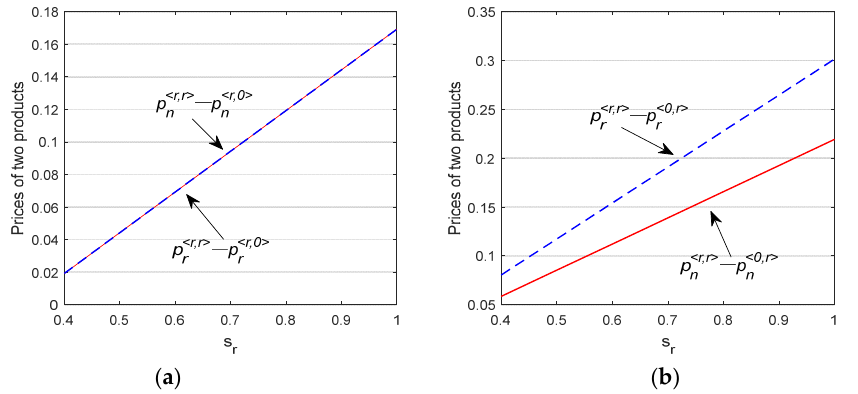
Figure 5. Price comparison under single subsidy policy. ( a ) <r , r> and < r , 0 >. ( b ) <r , r> and < 0 , r >.